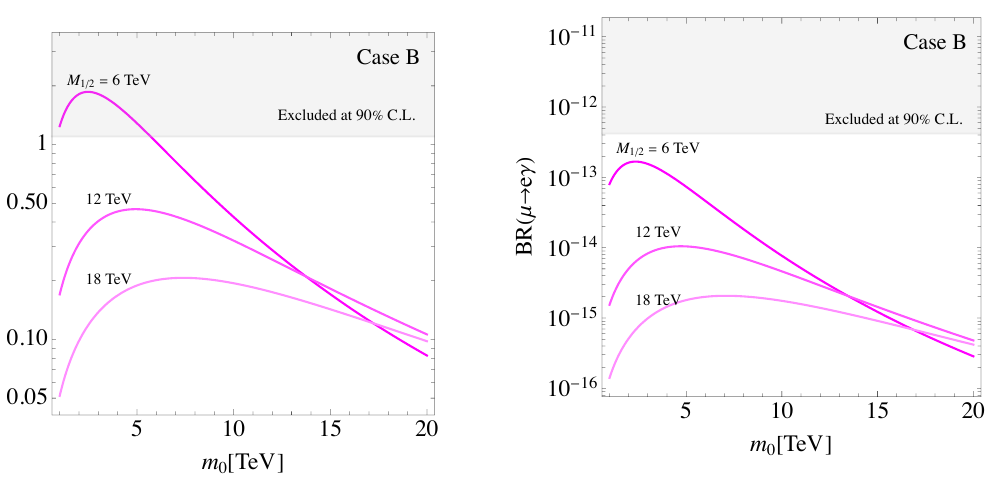
Figure 3 . The predicted | d e /e | versus m 0 with putting F τ = m 0 / 2 in case B. The grey region is excluded by the experimental upper bound.